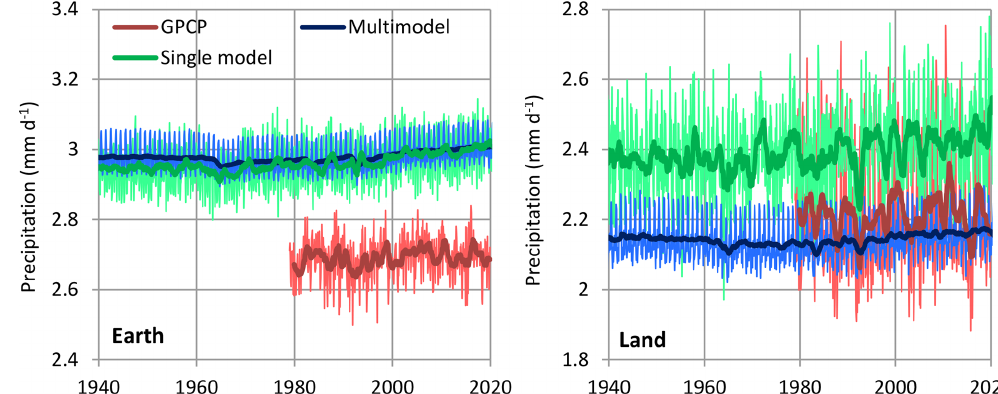
Figure 17. Comparison of climate model outputs (for the specification of which, see the text) with reality, as quantified by GPCP satellite observations. “Multimodel” refers to CMIP5 scenario runs and entries, namely CMIP5 mean – RCP8.5. “Single model” refers to the ensemble member 0 of the Community Climate System Model version 4 (CCSM4) – RCP8.5 released by NCAR. Thin and thick lines of the same colour represent monthly values and running annual averages (right aligned), respectively.